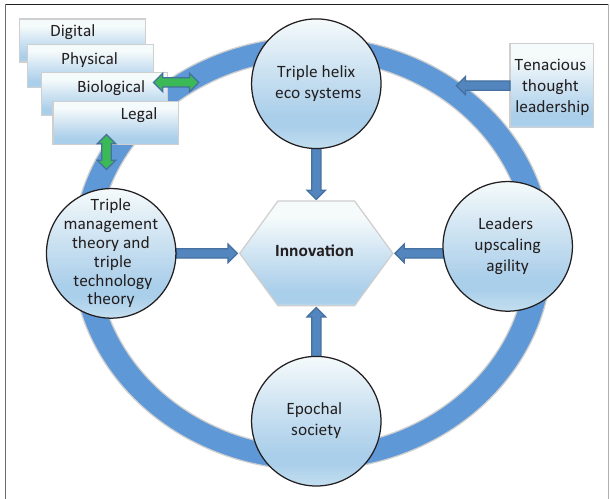
FIGURE 2: A hypothetical improvement of the quadruple helix model.